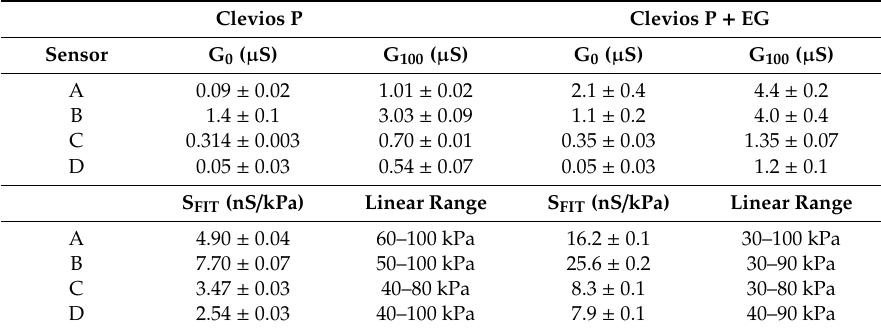
Table 2. Main parameters of textile pressure sensors useful to evaluate their